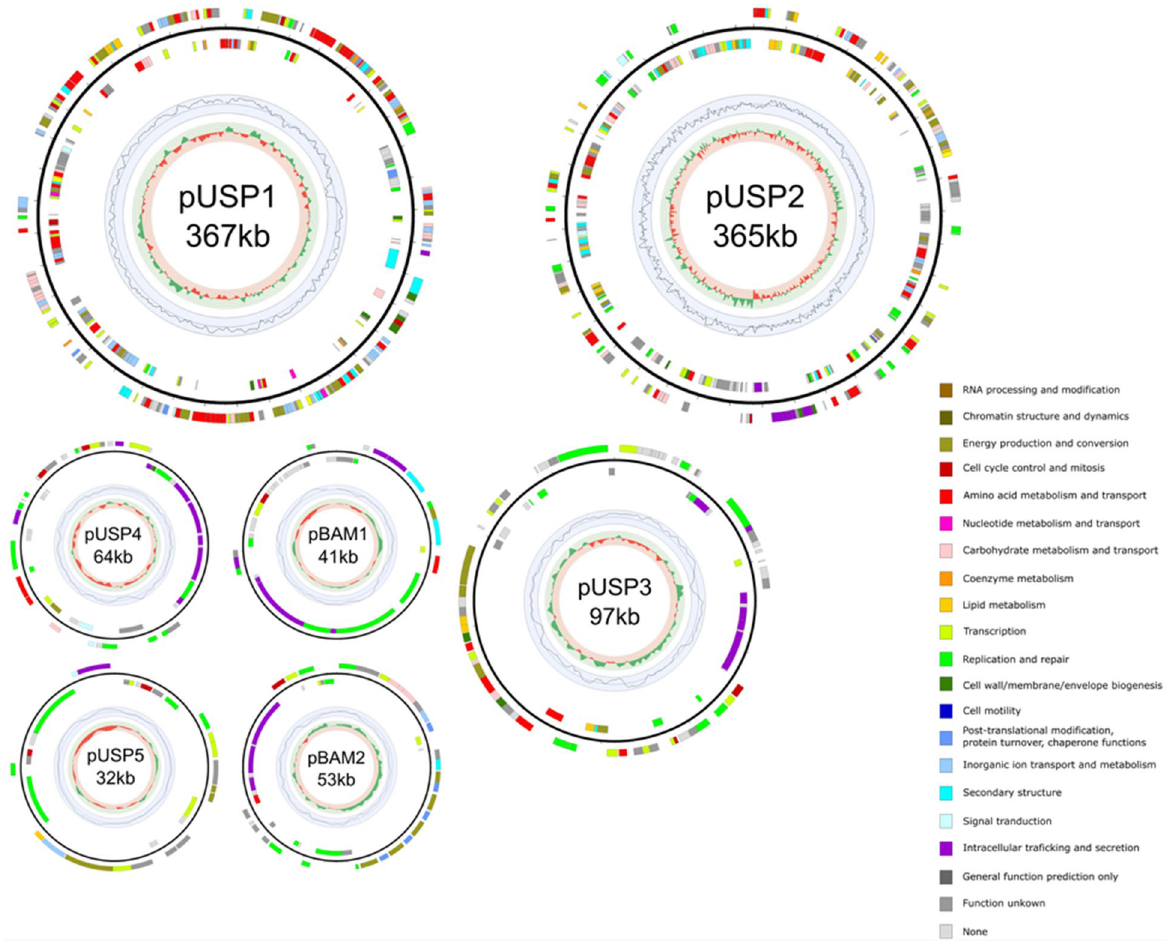
Figure 2. Circular view of the plasmids of the newly assigned Aminobacter niigataensis MSH1. From outer to inner circle: CDS on leading strand, scale (ticks: 100 kb), CDS on lagging strand, GC plot and GC skew (> 0: green, < 0: red). CDS are colored according to COG functional categories determined with EggNOG mapper 4.5.1. The KU Leuven substrain MK1 lacks plasmids